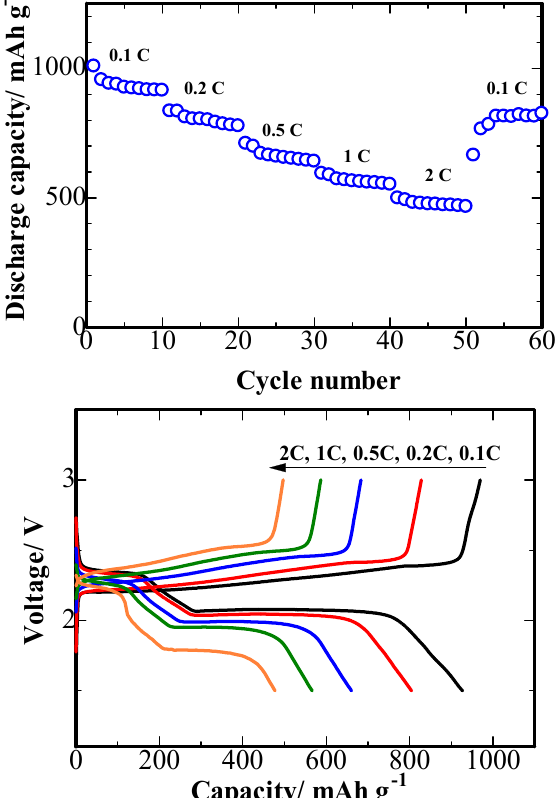
Figure 9. The rate performance of the S/PPy/PG composite electrode, measured by carrying out charge/discharge testing at various current rates.